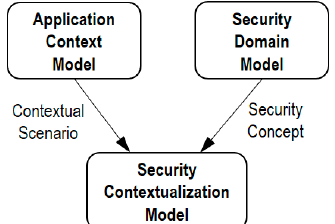
Figure 1. Three models span the modeling of contextualized security knowledge.